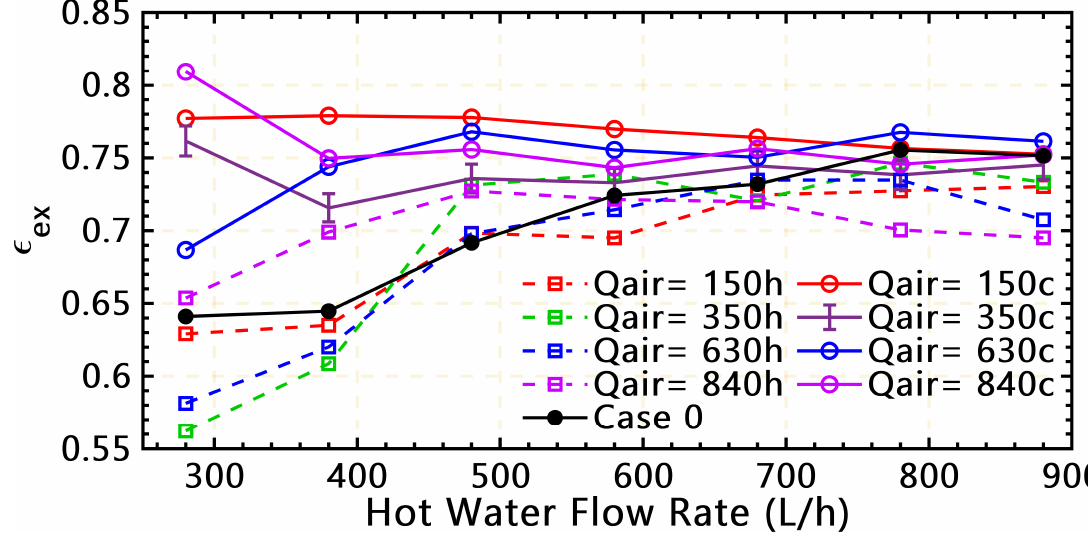
Figure 12. Relationship between ε ex and Q h for original case and, different ABI into both CWS and HWS.